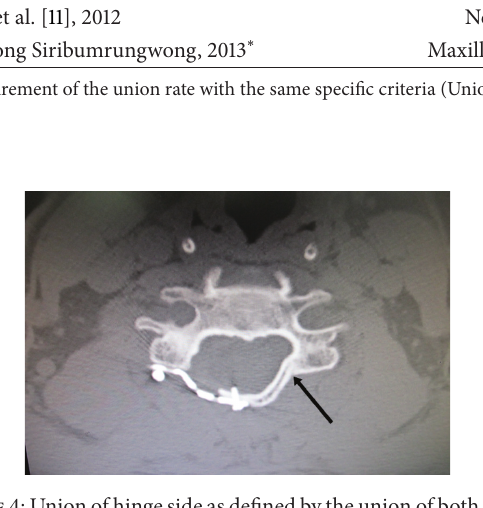
Figure 4: Union of hinge side as defined by the union of both dorsal and ventral cortices (arrow).